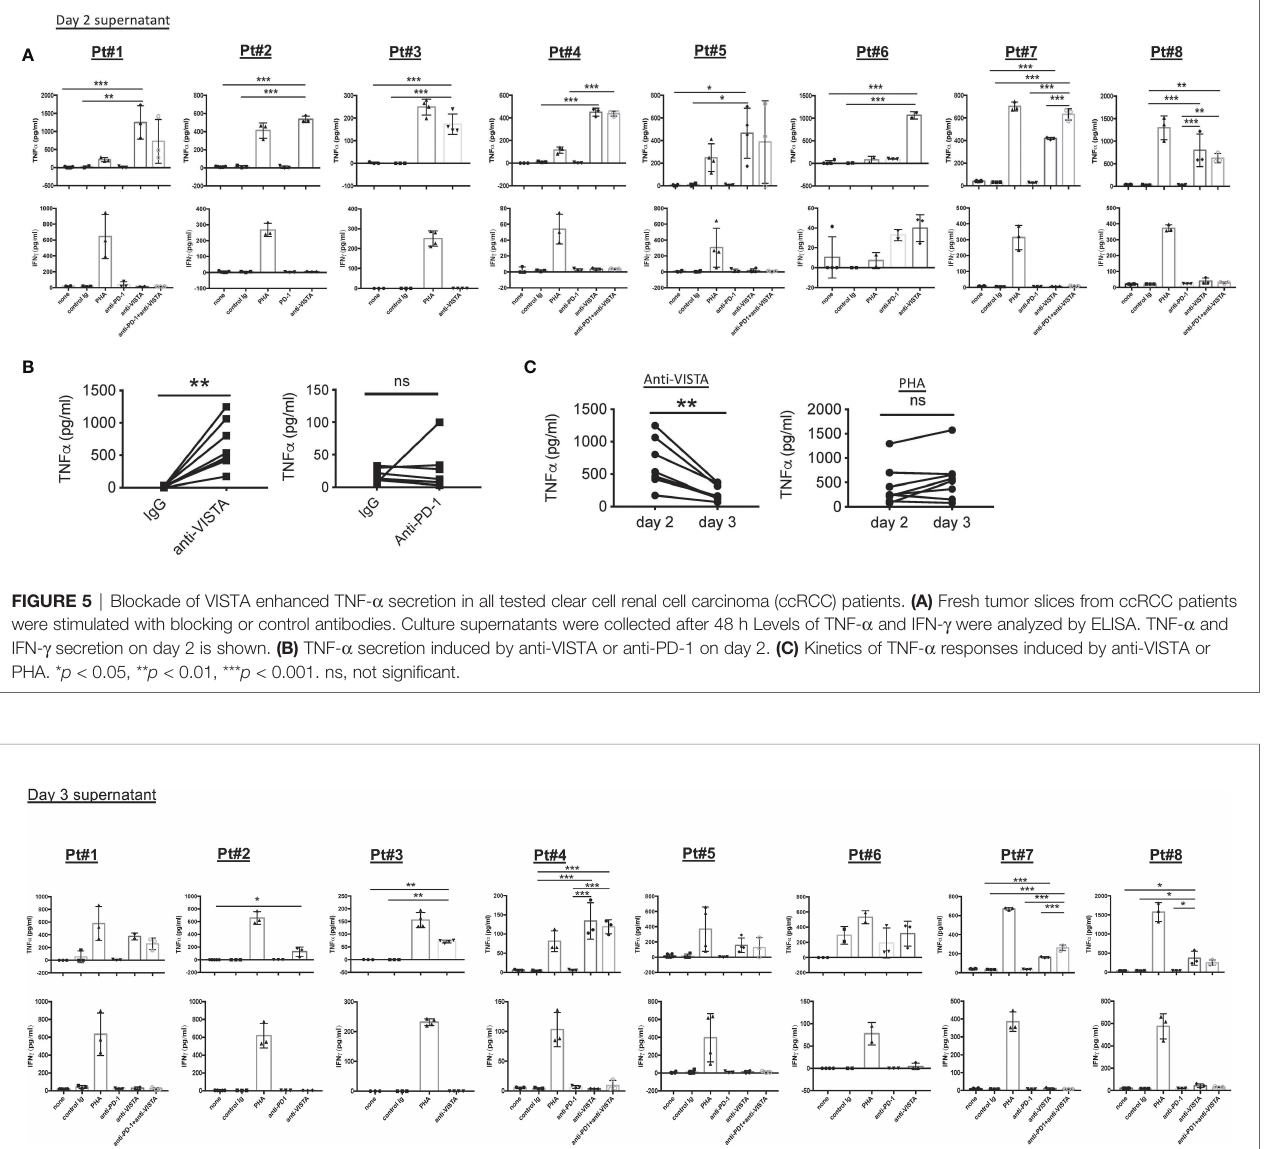
FIGURE 6 | Blockade of VISTA enhanced TNF- a secretion in all tested clear cell renal cell carcinoma (ccRCC) patients on day 3. Fresh tumor slices from ccRCC patients were cultured with blocking or control antibodies. Culture supernatants were collected after 72 h. Levels of TNF- a and IFN- g were analyzed by ELISA. TNF- a and IFN- g secretion on day 3 is shown. * p < 0.05, ** p < 0.01, *** p <